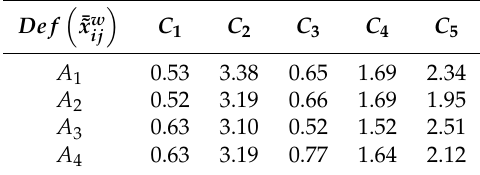
Table 5. The defuzzified weight decision matrix Def ( ¯˜ D ) .